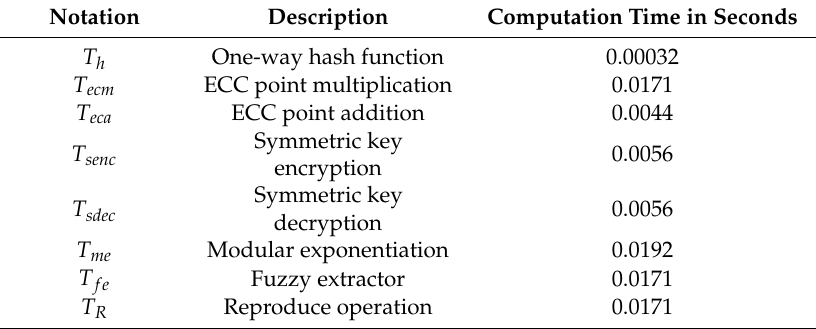
Table 5. Key sizes of the schemes.